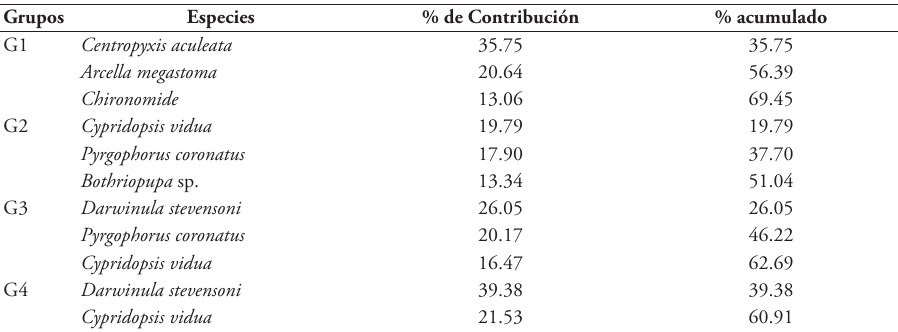
Table 3. SIMPER analysis results, showing the percentage of contribution of the species for the four ecological groups discriminated in the non-metric multidimensional scaling analysis. Grupos Especies % de Contribución % acumulado